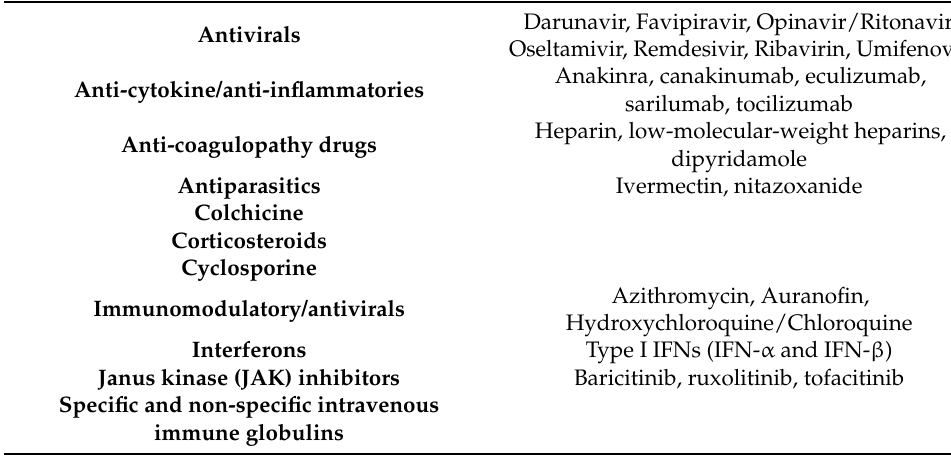
Table 6. The variety of current COVID-19